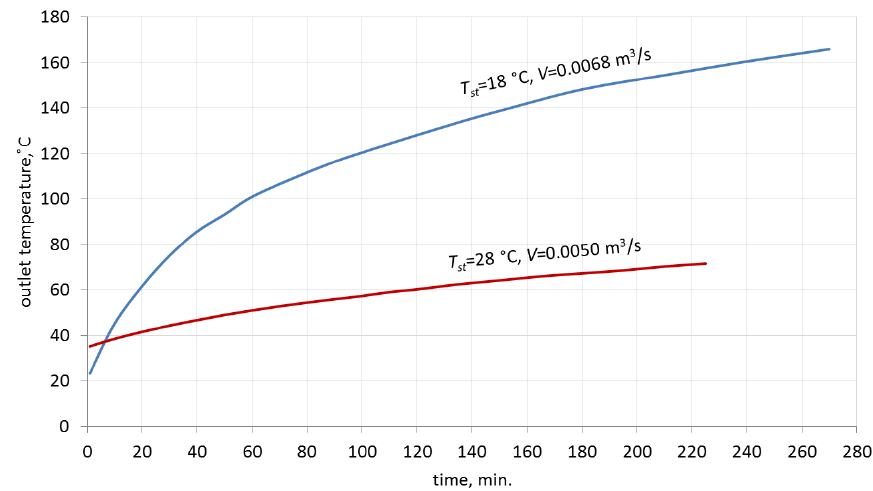
Figure 5. Change of outlet temperature as a function of charging time for two examined airflow rates.